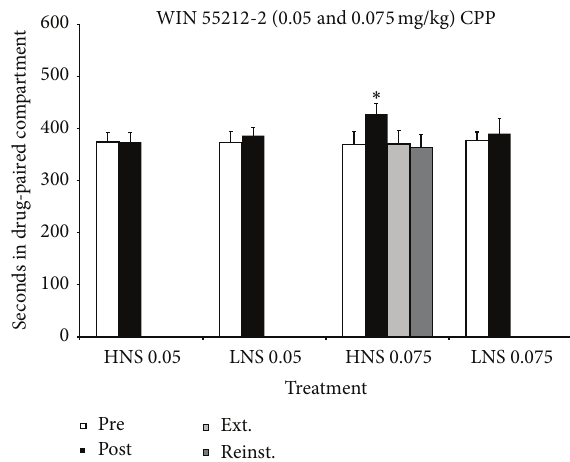
Figure 5: CPP induced by cocaine (1mg/kg) in HNS and LNS adolescent mice pretreated 6 days before initiation of conditioning with vehicle (HNS, 𝑛 = 15 ; LNS, 𝑛 = 14 ), 0.1mg/kg of WIN 55212-2 (HNS, 𝑛 = 13 ; LNS, 𝑛 = 12 ), or 1 mg/kg of rimonabant (HNS, 𝑛 = 14 ; LNS, 𝑛 = 13 ). Bars represent time in seconds spent in the drug-paired compartment during preconditioning (white), postconditioning (black), the last extinction session (light grey), and reinstatement (dark grey). Values are mean ± SEM. ∗∗ 𝑝 < 0.01 , difference with respect to the preconditioning session. ++ 𝑝 < 0.01 , difference with respect to the previous extinction